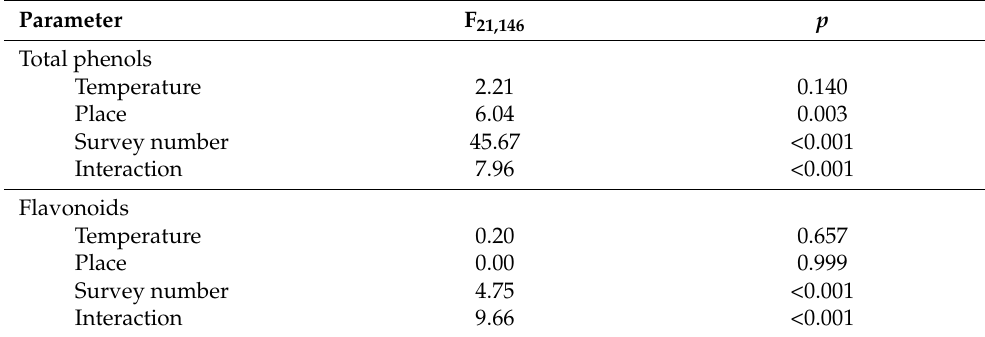
Table 1. The effects of temperature, place, survey number and interaction between studied pa- rameters on level of total phenols and flavonoids in V. opulus (general linear models GLM, normal error distribution).